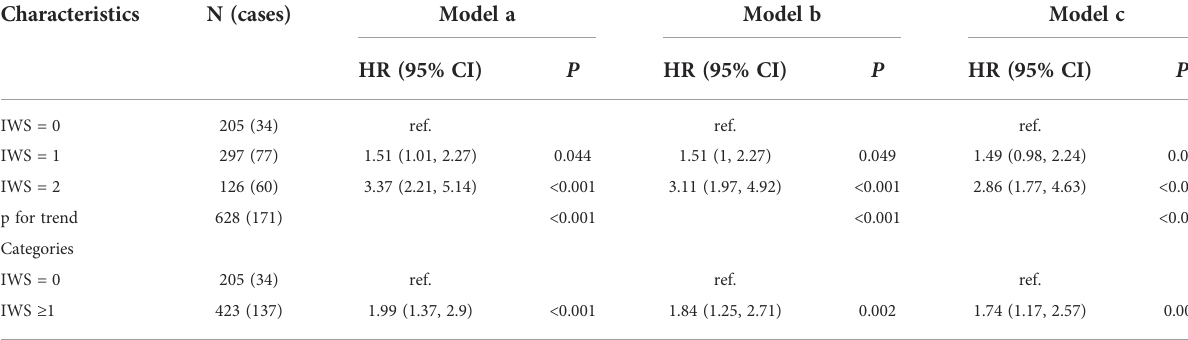
TABLE 4 Cox regression analysis of In fl ammation-water score associated with overall survival.